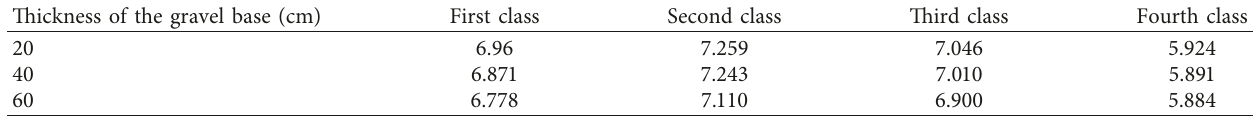
Table 4: Vertical deformation for the asphalt pavement thickness of 18cm.